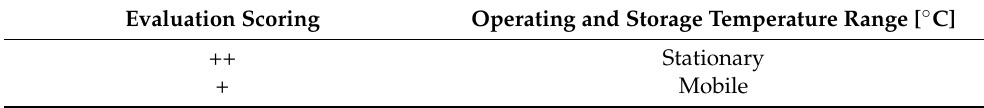
Table A5. Conversion table used for the degree of mobility.